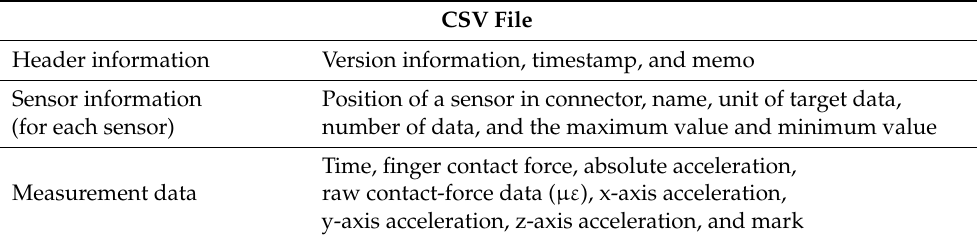
Table 1. Contents of the data output by HapLog.